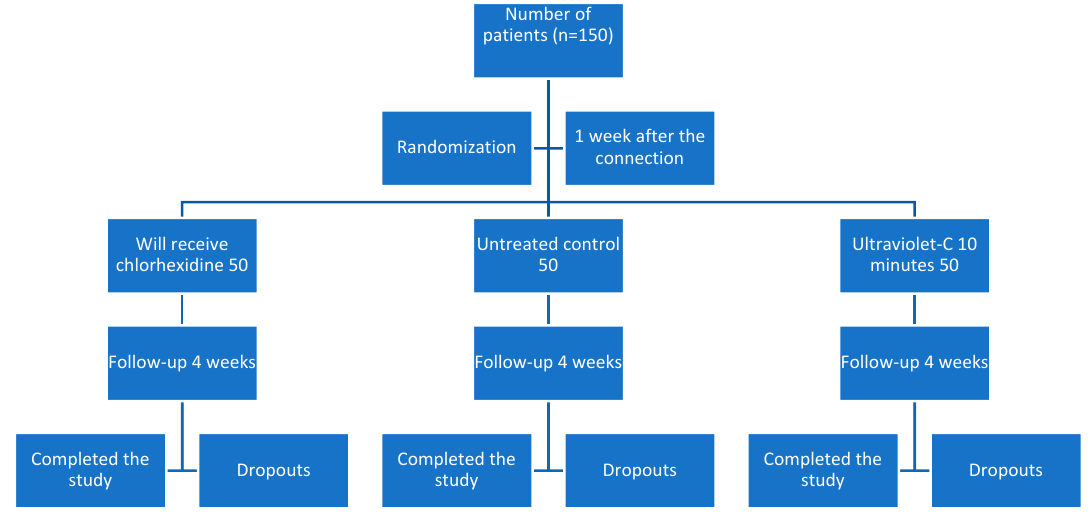
Figure 1. Protocol for distributing the studied sample and assigning them to the test and control group.